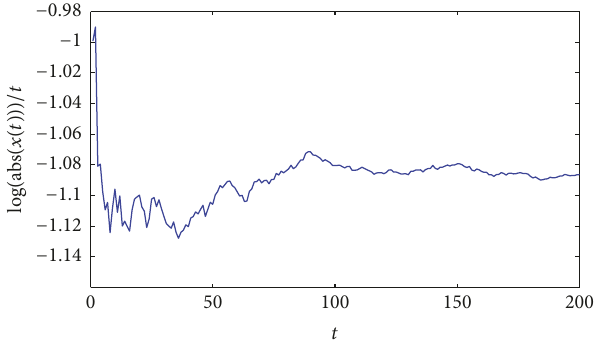
Figure 2: Computer simulation of ln |𝑥(𝑡)|/𝑡 of the solution 𝑥(𝑡) of